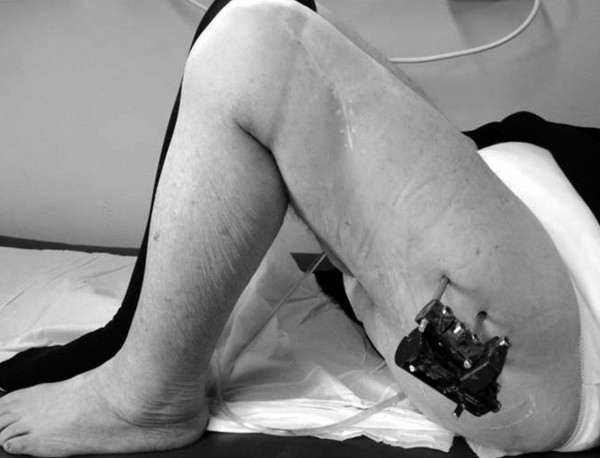
Postoperative range of motion. No clinically significant limitation of hip or knee range of motion was observed in patients of either group.